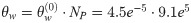
An example of semantic network visualization.We show the network obtained for the window 2000–2004, with parameters θc = 0.06 and θw=θw(0)·NP=4.5e-5·9.1e5. The corresponding file in a vector format (.svg), that can be zoomed and explored, is available as S1 File.